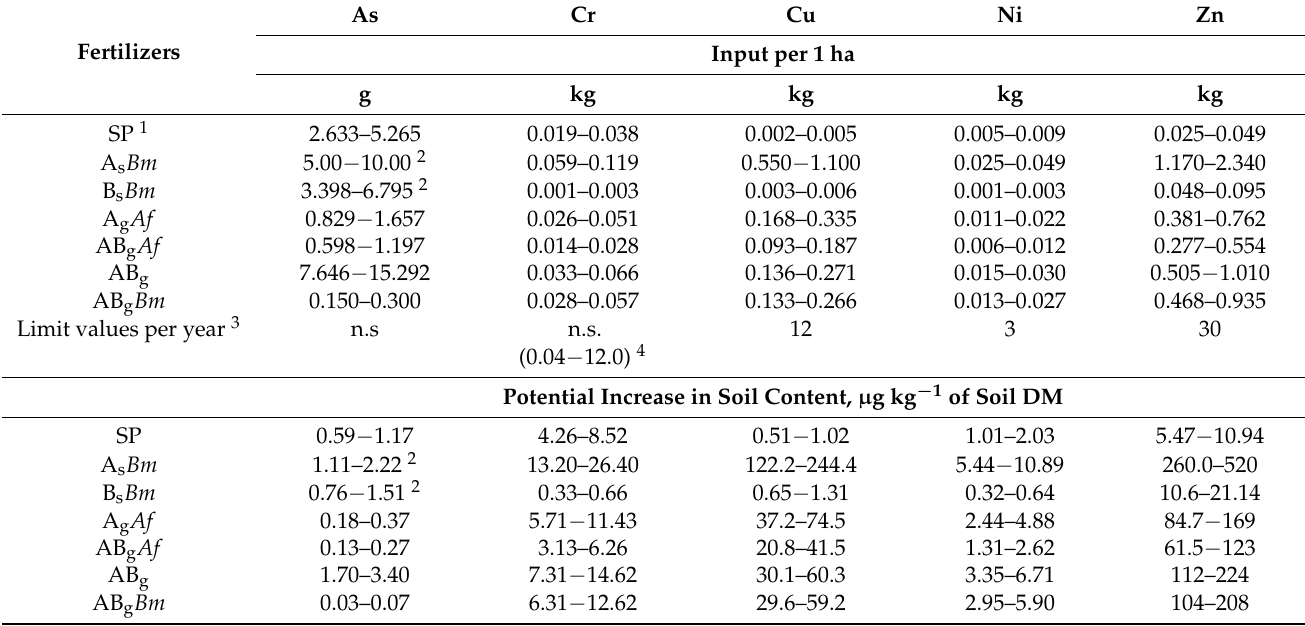
Table 9. PTE amounts introduced into soil with P -fertilizers applied—range between the values for the lowest (17.6 kg · ha − 1 ) and the highest (35.2 kg · ha − 1 ) P